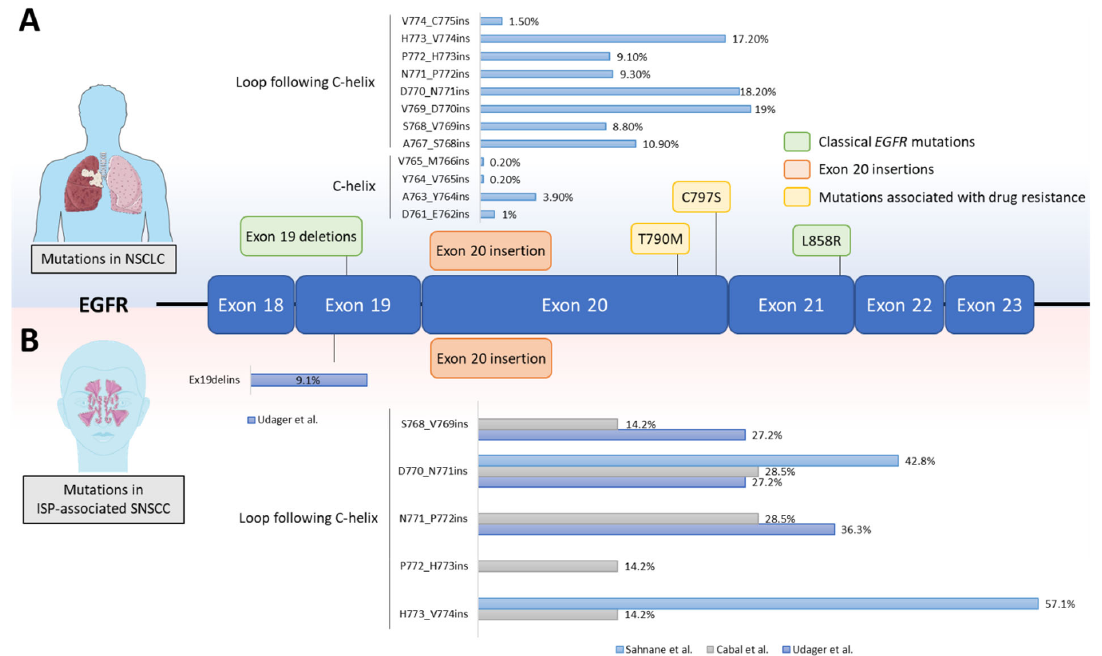
Figure 2. EGFR mutations in NSCLC and ISP-associated SNSCC. A schematic representation of the EGFR kinase domain is shown. ( A ) All EGFR mutations in NSCLC are clustered across exon 18–22, which encode the tyrosine kinase domain. The most common EGFR mutations in NSCLC are referred to as ‘classical’ EGFR mutations (green) and account for approximately 85% of all EGFR mutations in NSCLC patients. The point mutations T790M and C797S (yellow) are associated with resistance to first- and third-generation EGFR TKIs, respectively. The prevalence of exon 20 insertions (orange) in NSCLC that occur at different amino acid positions are shown in the bar chart. Mutation frequency distribution was calculated using COSMIC v86 (http://cancer.sanger.ac.uk, 10 November 2021) after filtering for NSCLC adenocarcinoma patients with exon 20 insertions ( n = 383) [55]. ( B ) Frequency of exon 20 insertions and exon 19 deletion ‐ insertion in ISP ‐ associated SNSCC across 3 different studies are shown in the bar charts [19,20,56].